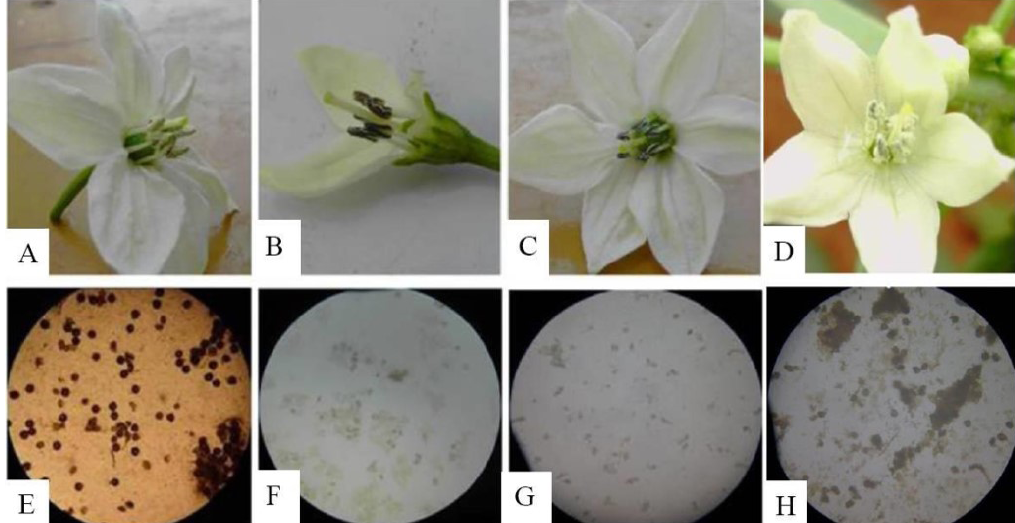
Figure 1 ‒ Morphology and pollen viability of TP6, SP23, CMS-14A, and ML-14B. A: Blooming flowers of ML-14B had many pollen gains on the stamen; B: blooming flowers of TP6 had few pollen gains on the stamen; C: blooming flowers of CMS-14A had no pollen gain on the stamen; D: blooming flowers of SP23 had plenty of pollen gains on the stamen; E: most pollen gains from ML-14B appeared round and dark stained with I most pollen gains from TP6 appeared empty and deflated stained with I pollen gains from SP23 appeared round and dark stained with I